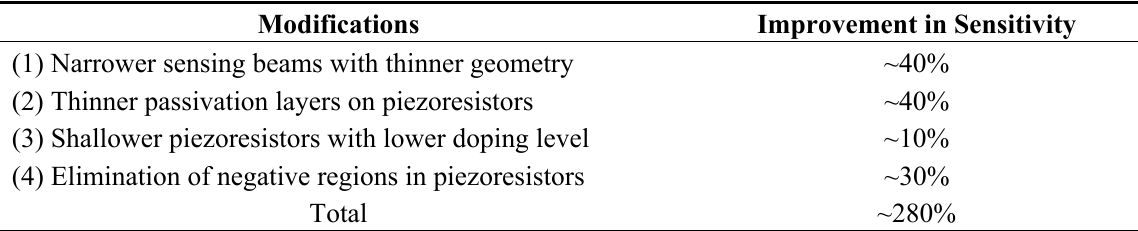
Table 1. Summary of the modifications made in the present study and the improvement in sensitivity compared to the